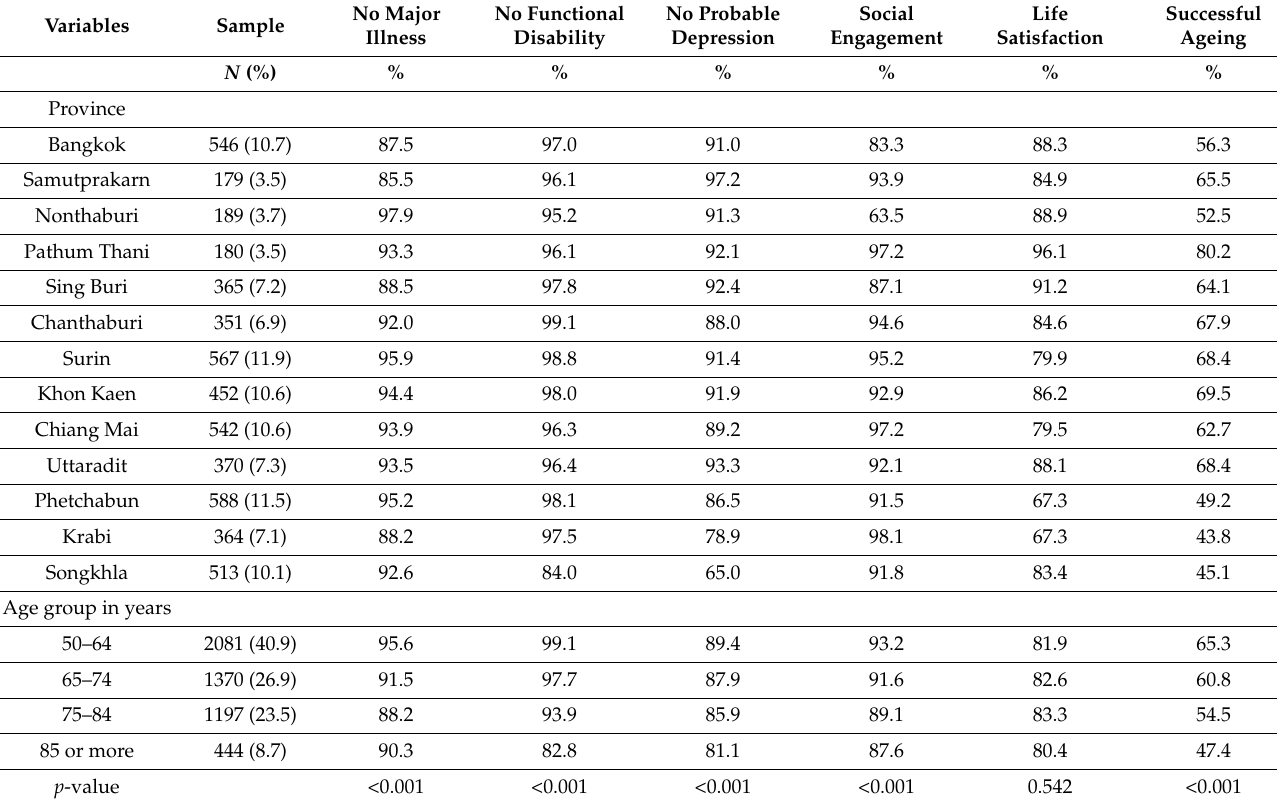
Table 2. Sample and successful ageing characteristics in older adults ( ≥ 50 years) in Thailand, 2015, by province and age group.